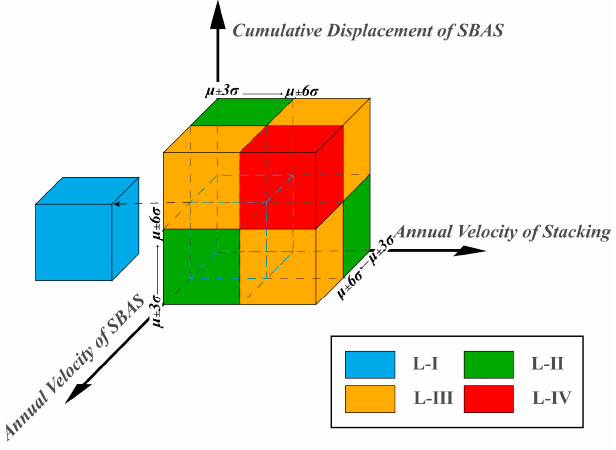
Figure 6. Landslide gradation model. Red (L-IV) represents the highest grade of deformation, and blue (L-I) represents the lowest grade of deformation.